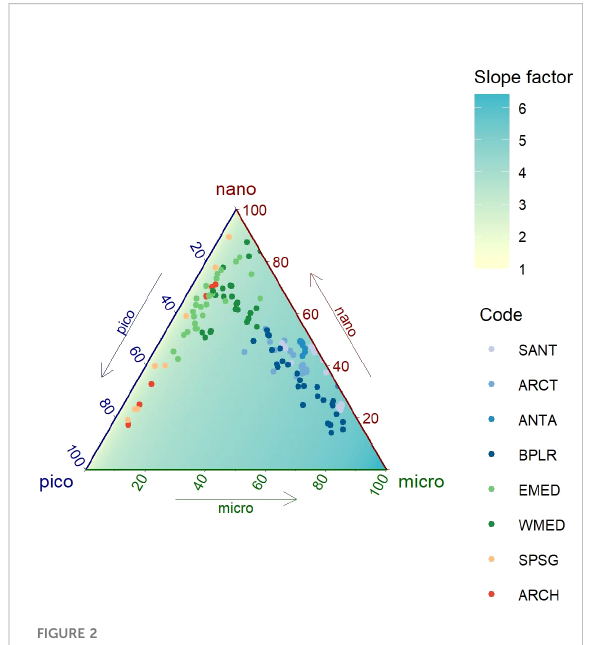
FIGURE 2 Ternary diagram of the pigment-based relative contribution to the Chla concentration of three phytoplankton size classes (micro-, nano-, and picophytoplankton) in the global Glo-Argo dataset. The color of the background indicates the value of the [Chla] fl uo /[Chla] HPLC ratio extrapolated with a linear regression model. The color of the datapoints indicates the corresponding bioregions (ANTA, Antarctic Province; ARCH, Archipelagic Deep Basin Province; ARCT, Atlantic arctic Province; BPLR, Boreal Polar Province; EMED, Eastern Mediterranean Sea; SANT, Subantarctic Province; SPSG, South Paci fi c Subtropical Gyre Province; WMED, Western Mediterranean